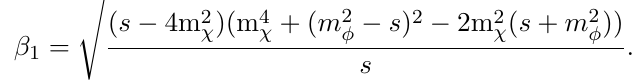
Figure 11 . Contours of (cid:12)xed e(cid:11)ective CP-violation parameter of the complex phase (cid:18) = arg( (cid:21) ) and the e(cid:11)ective pair-annihilation coupling (cid:21) 2 . The results are shown for two di(cid:11)erent DM mass values m (cid:31) = 1 TeV (left panel) and 5 GeV (right panel). The required values of the annihilation rates and (cid:15) e(cid:11) are reproduced, as indicated. See text for details, and (cid:12)gure 7 for comparison with the results obtained in the model-independent